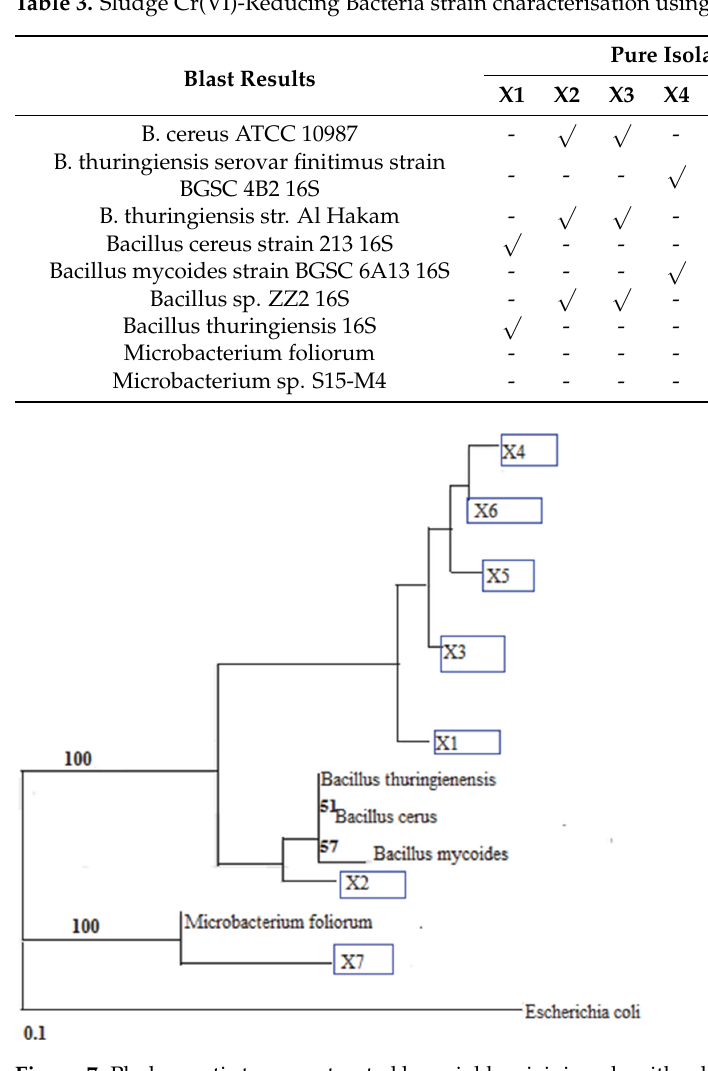
Figure 7. Phylogenetic tree constructed by neighbor-joining algorithm based on the partial 16S rRNA gene sequences and 1000 bootstrap replicates, showing the microbial diversity of Cr(VI) reducing consortium from Sludge C under aerobic